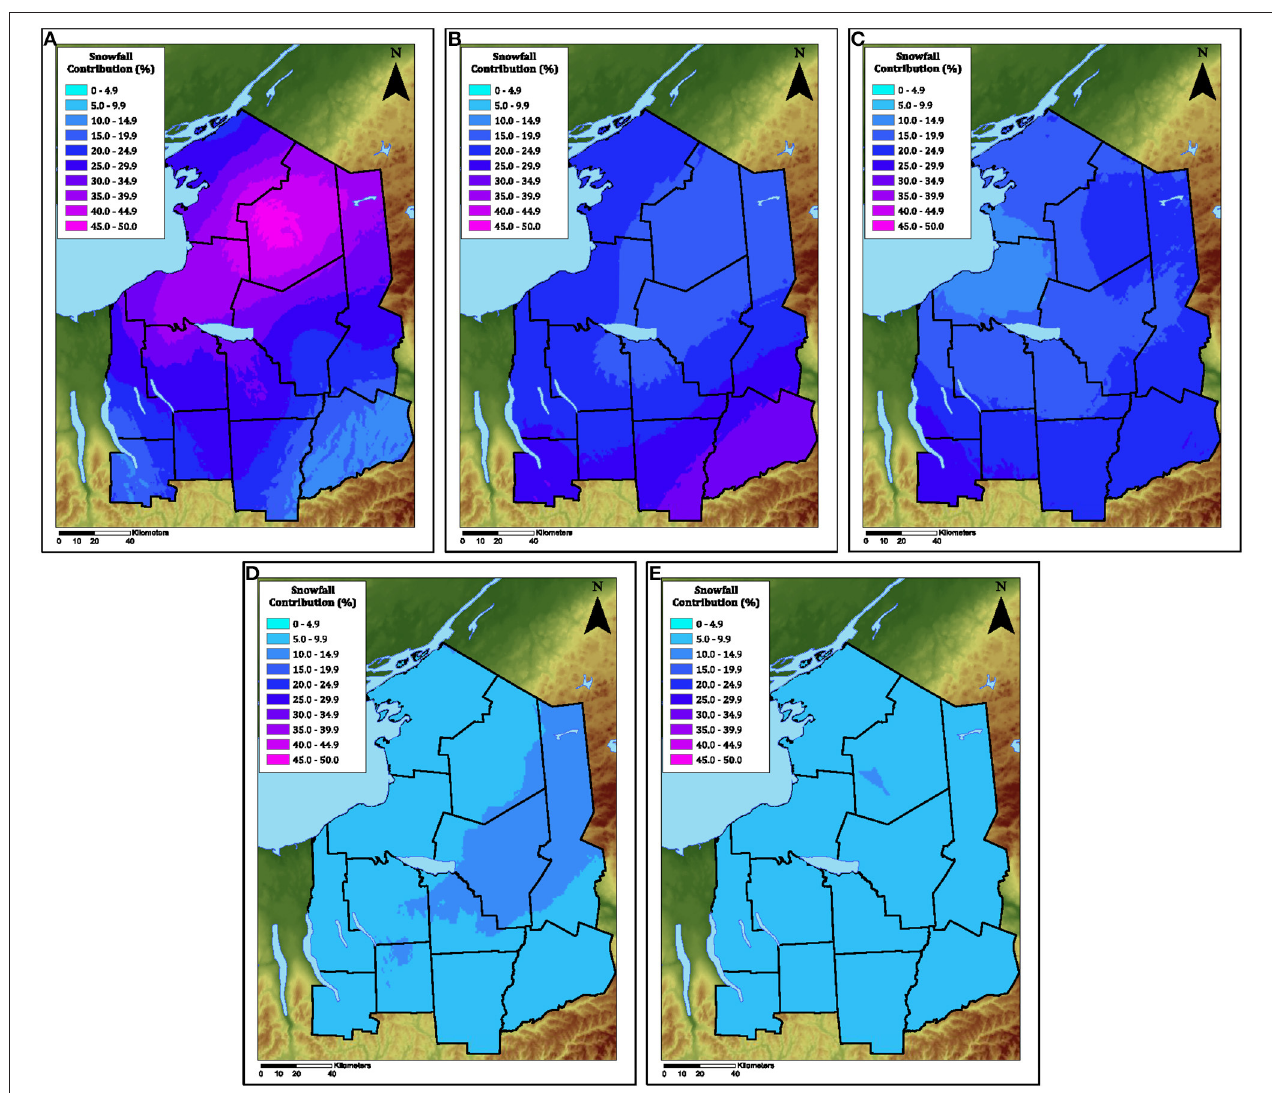
FIGURE 5 | Seasonal snowfall contributions for the five different snowstorms to affect Central New York from 1995/96 to 2014/15. Figures include contributions from lake-effect storms (A) , Nor’easters (B) , Rocky lows (C) , Canadian lows (D) , and non-cyclonic storms (E)